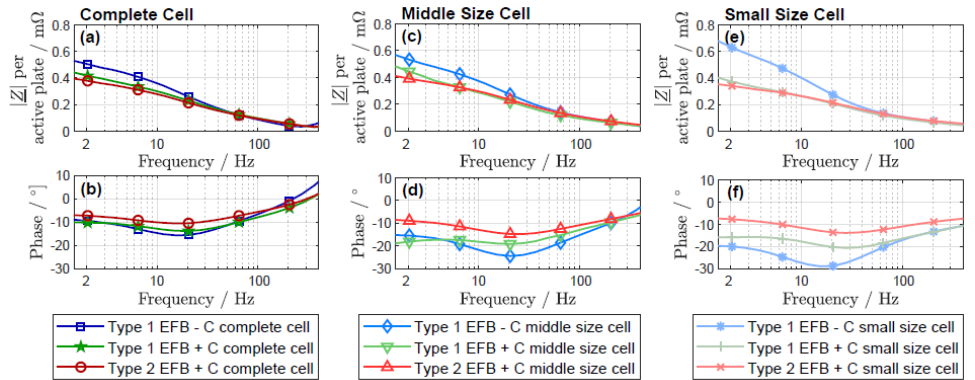
Table 3. Scaling factors according to the number of active plates within a cell (Reprinted from Ref. [16]).